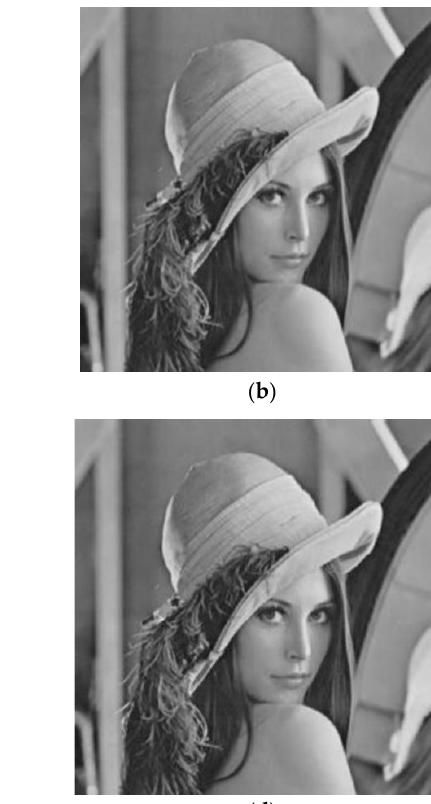
( b ) Figure 4. Comparison of eye effects of the nearest neighbor interpolation and the proposed rational interpolation. ( a ) The zoomed images by factor 4 based on the nearest-neighbor interpolation method, ( d ) the zoomed images by factor 4 based on the proposed method. 5. Conclusions and Future Work In this paper, by strategically selecting the multiplicity of the interpolation nodes, we have developed many types of univariate and bivariate Thiele-like rational interpolation continued fractions with parameters. We also discussed the interpolant algorithms, interpolant theorems, and